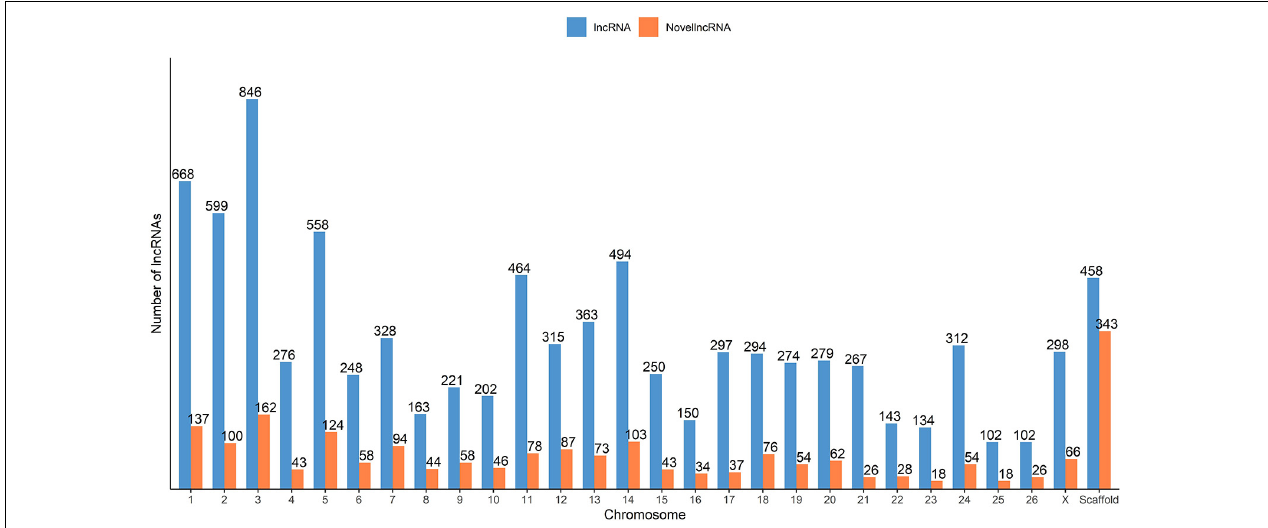
FIGURE 2 | Distribution of the predicted putative lncRNAs across the sheep genome from the merged ALN RNA-seq datasets of the 12 ALN sheep transcriptome samples under